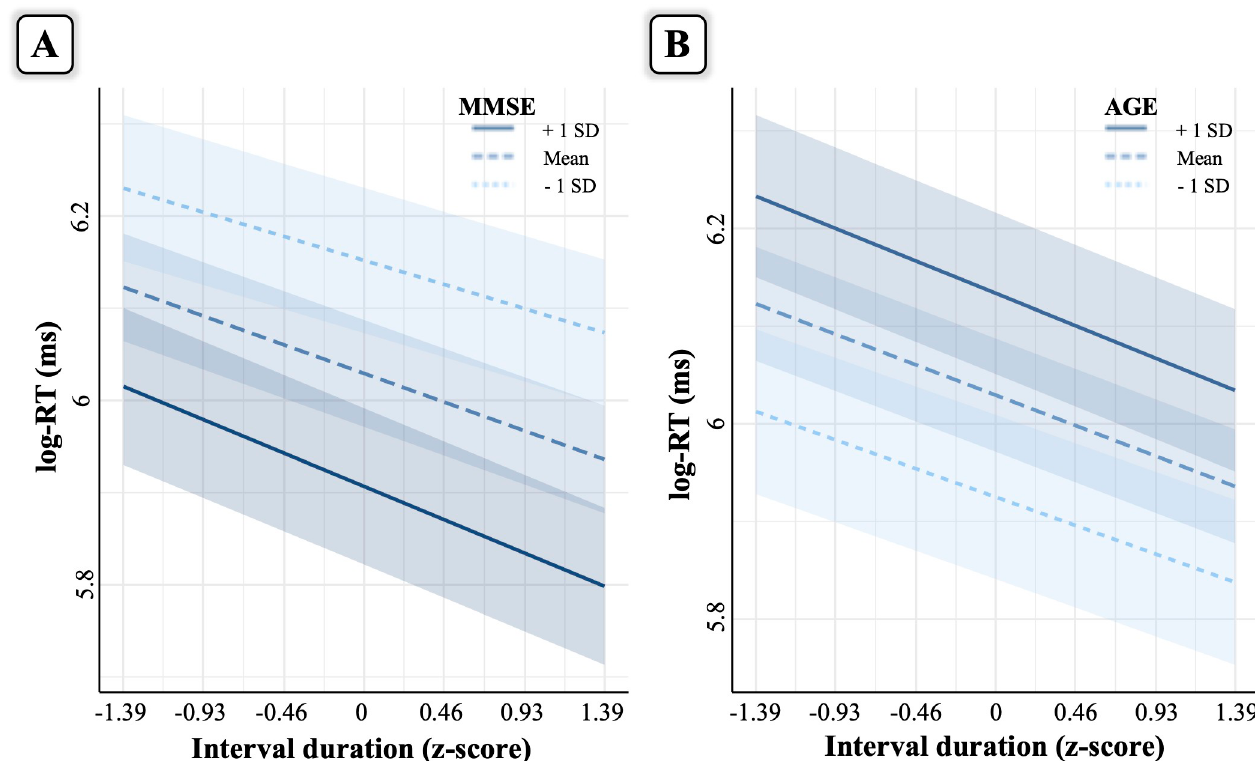
Fig 4. Interaction effects in the implicit timing task. Panel A depicts the interaction between Interval duration and MMSE, whereas panel B depicts the interaction between Interval duration and Age. The seven interval durations on the x-axis represent the actual durations used in the task. Please refer to Fig 3 for a detailed explanation of the interaction